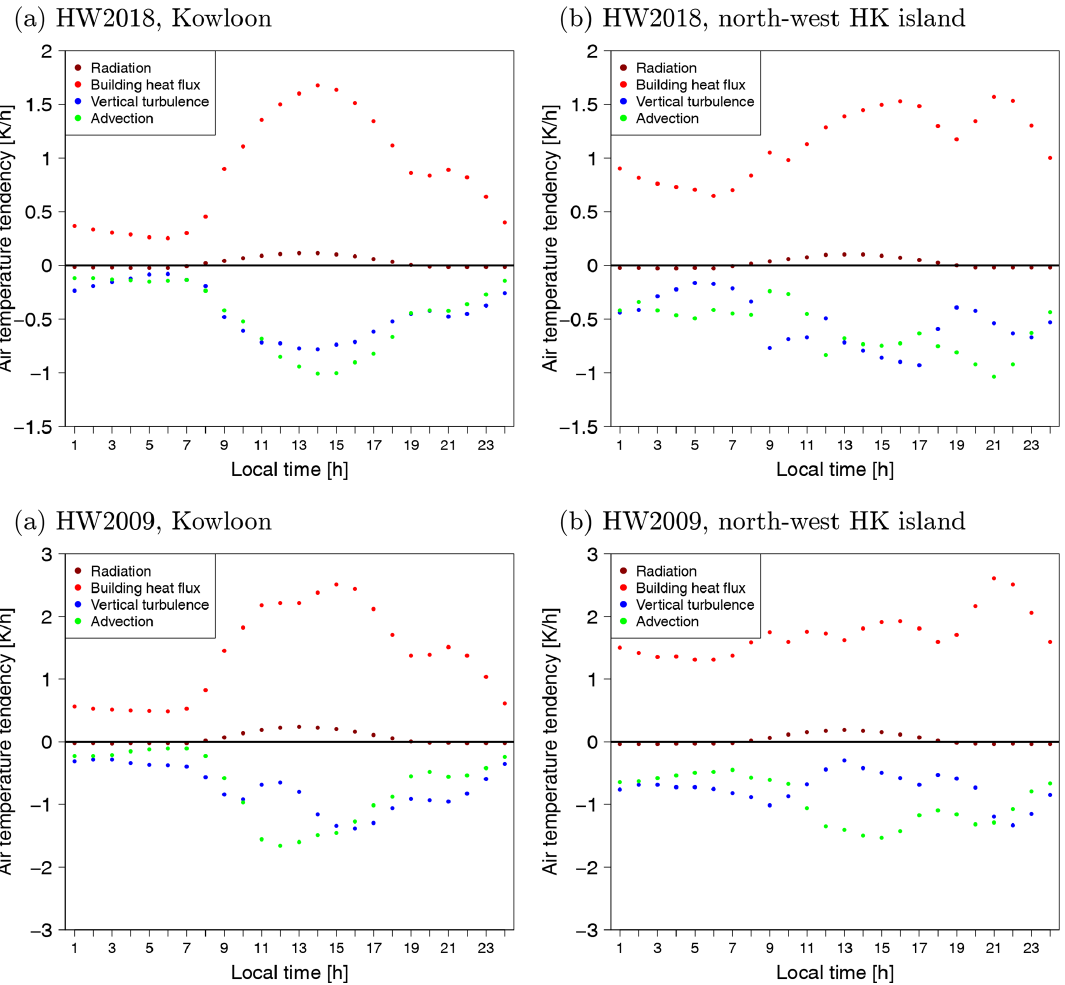
Figure 14. Daily cycle of the most relevant terms in the prognostic equation for the potential temperature for the NEW coupling approach in the lowest 30m of the atmosphere for the two boxes covering the Kowloon Peninsula and the north-west of Hong Kong Island displayed in Fig.